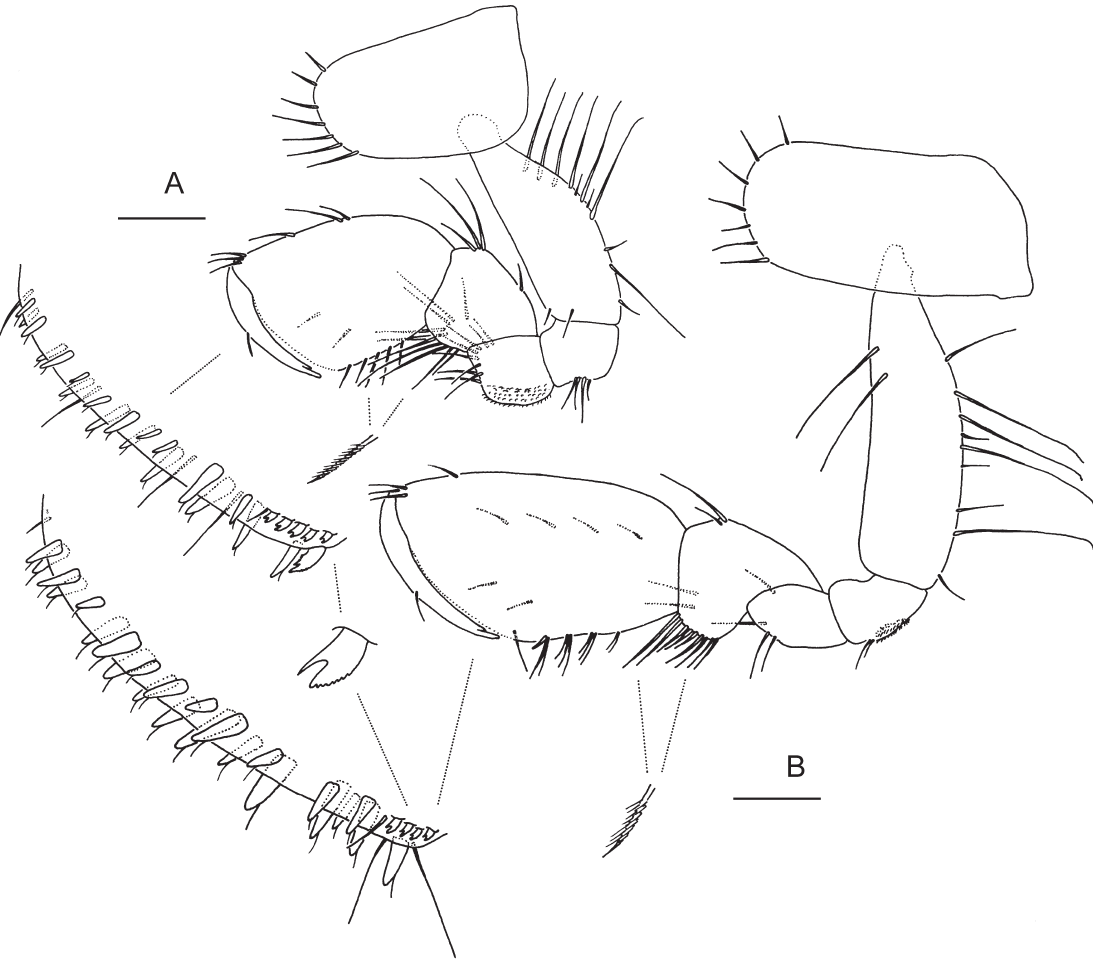
Fig. 3A-B. Synurella ambulans (F. Müller, 1846), ♂, 4.5 mm, FENU X34906/Cr-1406, MO. A . Gnathopod 1. B . Gnathopod 2. Scale bars 0.2